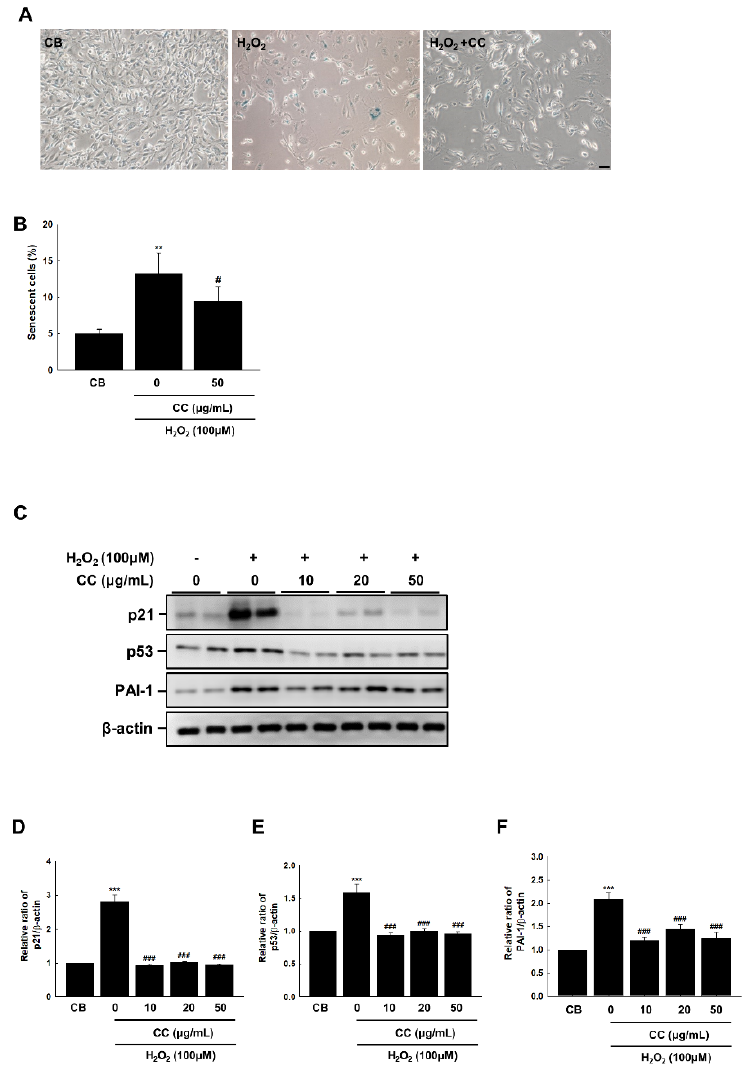
Figure 1. ( A ) Chrysanthemum coronarium L. (CC) extract reduces the senescent phenotype in H 2 O 2 (100 µmol/L)-stimulated HUVECs, as shown by β -gal staining. The magnification was set to 40 × . Scale bar = 50 µm. ( B ) Quantitative analysis of positive SA- β -gal stained cells. Data shown are derived from three independent experiments and expressed as the mean ± SEM (n = 6 per group). ( C ) CC reduced the expression of p21, p53, and PAI-1 induced by H 2 O 2 . ( D – F ) The relative ratios from comparison to β -actin in duplicate blots are shown in a graph chart. Control cells (CB) received the vehicle alone. The T Data shown are derived from three independent experiments and expressed as the mean ± SEM ( n = 6 per group). **, p < 0.01, ***, p < 0.001, versus CB; #, p < 0.05, ###, p < 0.001, vs. H 2 O 2 .